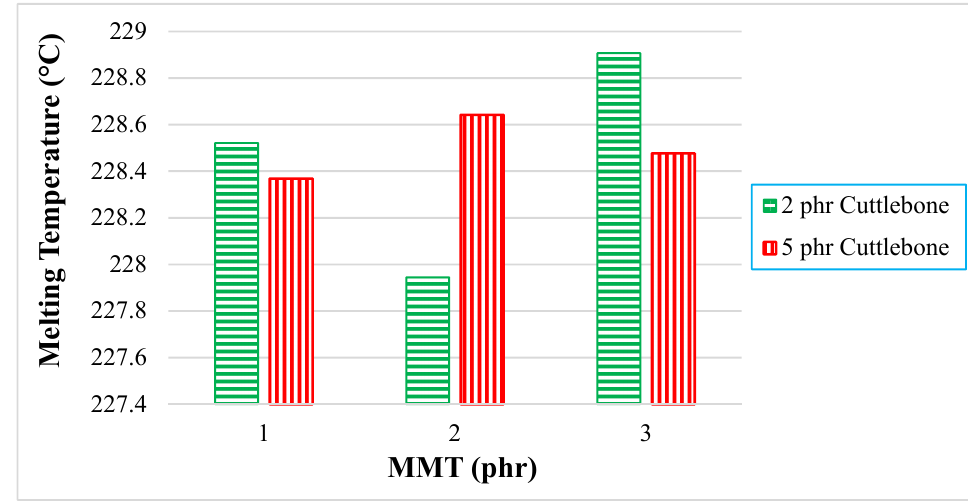
Figure 3. Effect of increasing MMT and calcined cuttlebone loading level on melting temperature.